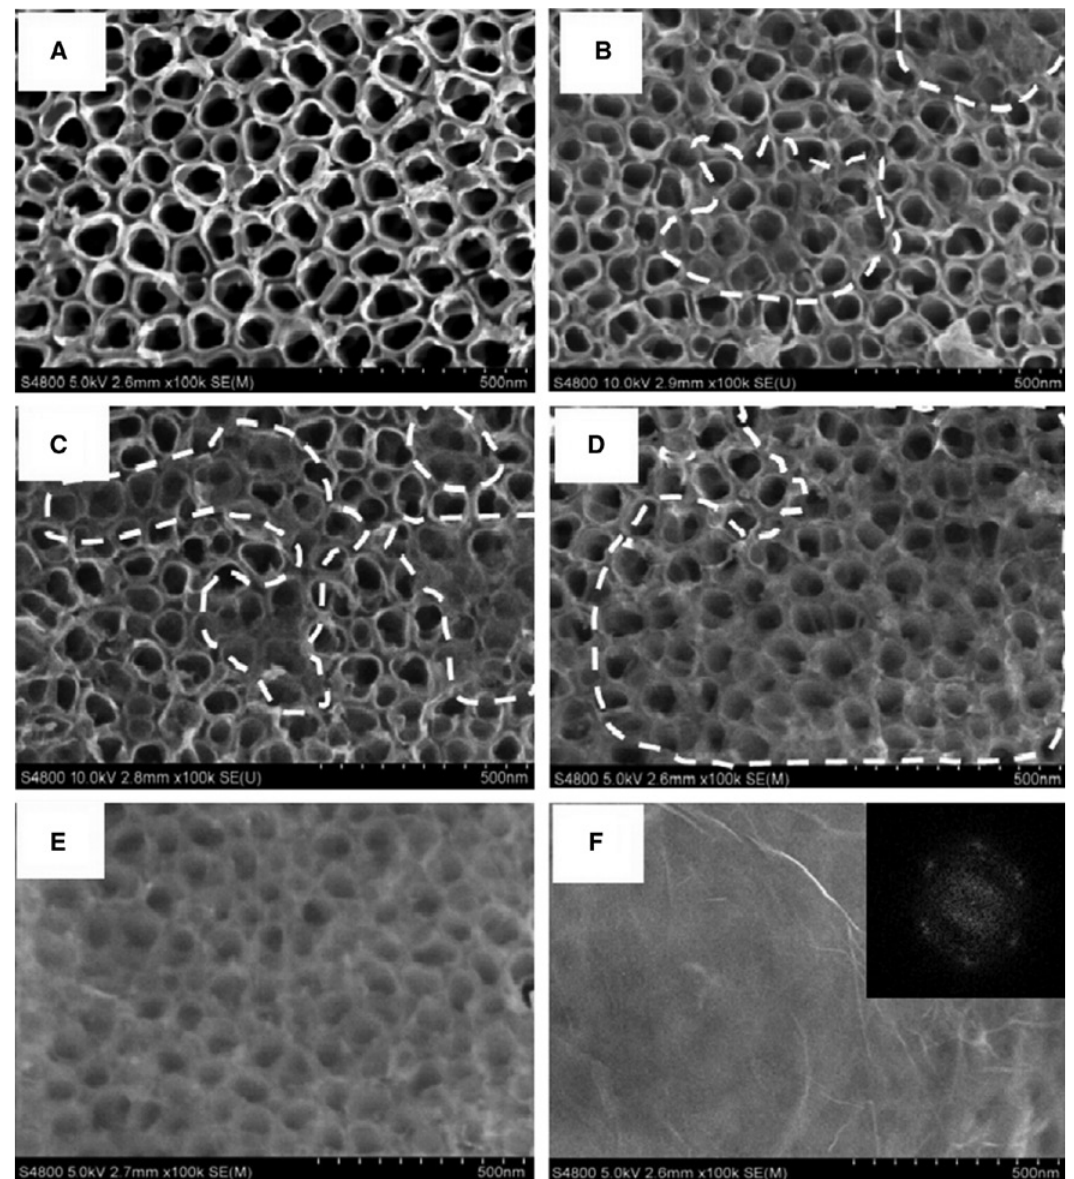
NTAs (A), and TiO NTAs covered by graphene electrodeposited with five cycles (B), 11 cycles (C), 17 cycles Figure 10: SEM images of TiO 2 2 (D), 26 cycles (E), and 32 cycles (F). Partial graphene islands are marked by the dashed lines for the eye guide. The inset (F) is a typical FFT image from photoreduced graphene sheets. Reproduced from Ref. [124] with permission. Copyright Elsevier.